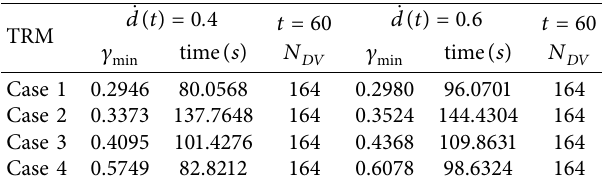
Table 2: Performance comparison results for four different cases of full-order FDFs with time-varying delays.